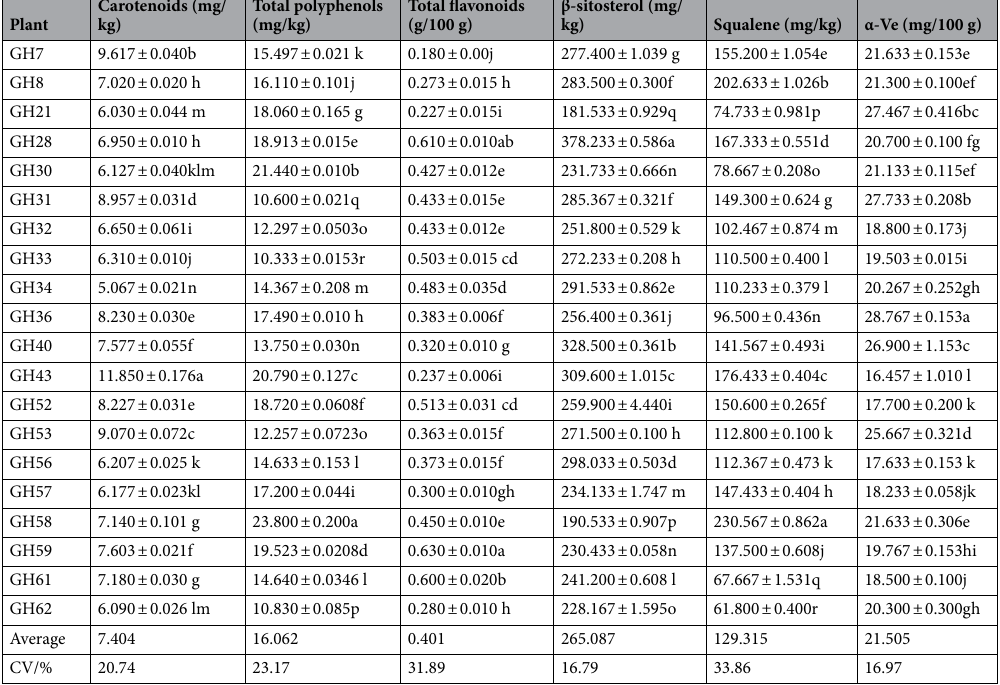
Table 3. Nutritional composition of seeds and oils of 20 strains of Wangmo red ball Camellia oleifera. The data in the table are the mean ± standard deviation; the same letters in the same line indicate no significant difference ( P > 0.05), while different lowercase letters in the same line indicate a significant difference ( P < 0.05). CV stands for coefficient of variation.